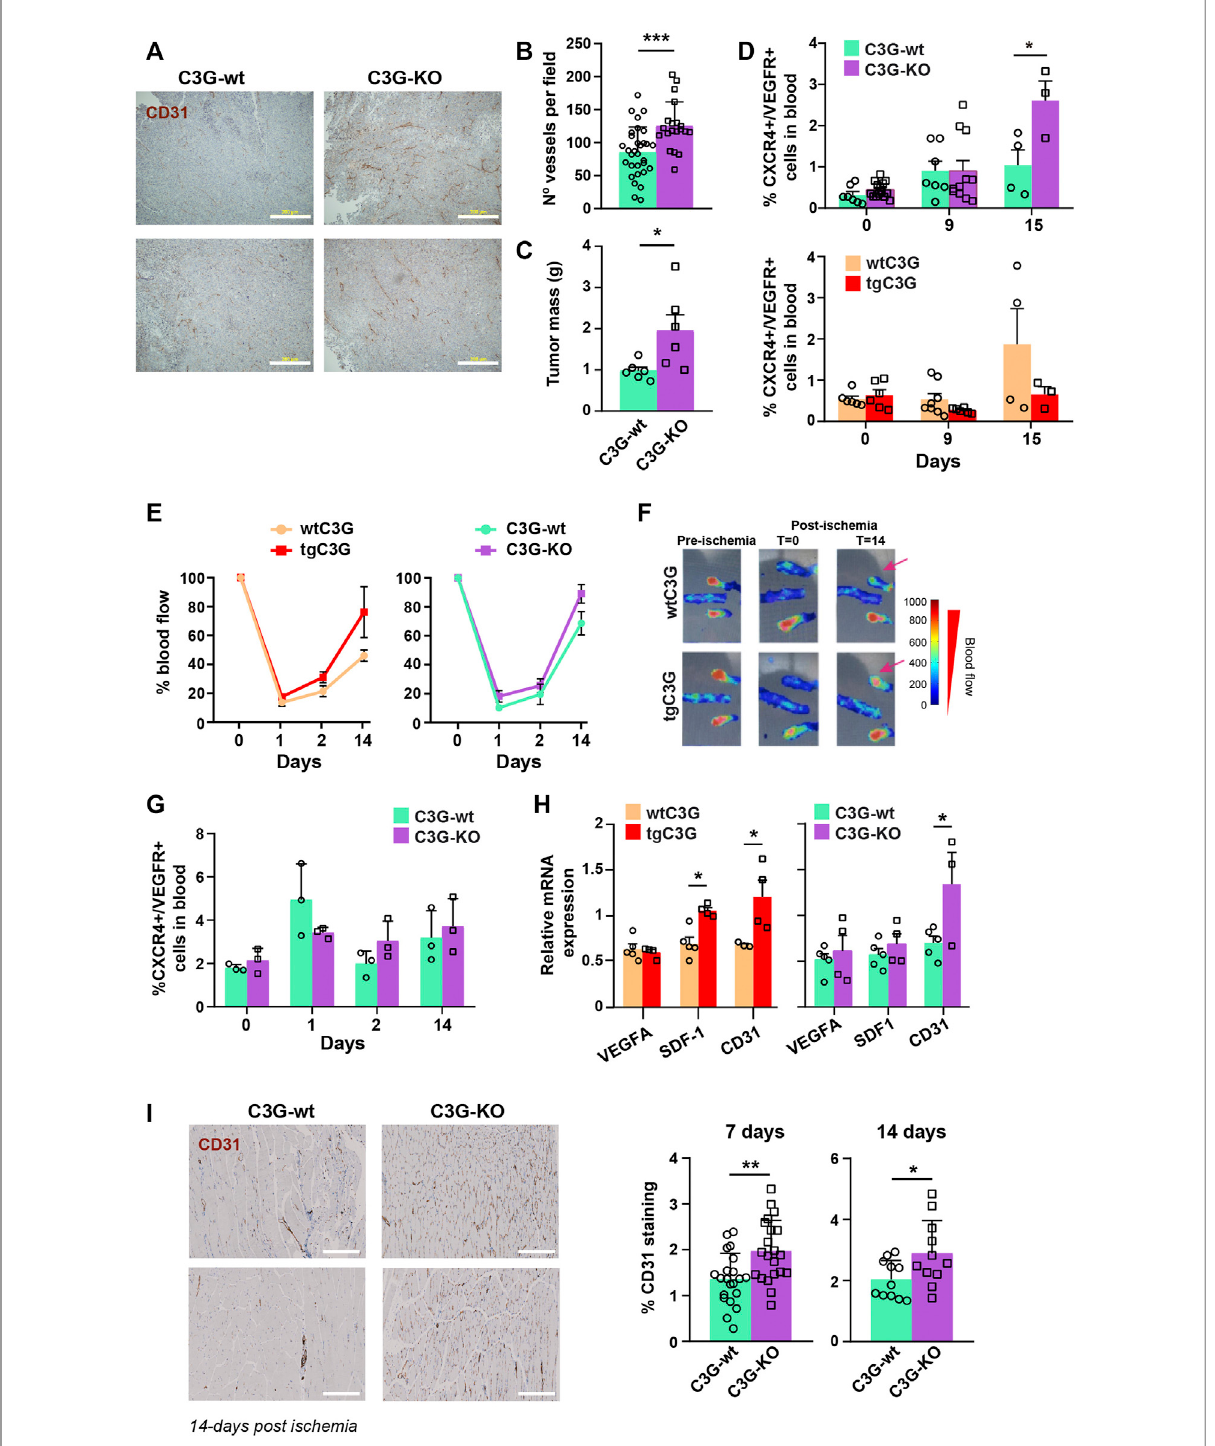
FIGURE 1 Platelet C3G regulates ischemia-induced angiogenesis. (A) Representative images of 3 LL tumor sections, from C3G-wt and C3G-KO mice, showing vessel density detected by CD31 staining. Bar: 200 μ m. (B) Quanti fi cation of the number of vessels per fi eld (0.65 mm 2 ) in tumor sections (Mean ± SEM). (C) Mean ± SEM of the tumor mass (in grams). (D) . Mean ± SEM of the percentage of hemagiocytes (CXCR4/VEGFR double-positive cells). (E) Dopplervaluesrepresentedasthemean±SEMofthepercentageofblood fl ow(n=6tgC3GandwtC3G,n=3C3G-KOandC3G-wt). (F) Representative Doppler images at the indicated times. The color scale represents the blood fl ow values. (G) Mean ± SEM of the percentage of